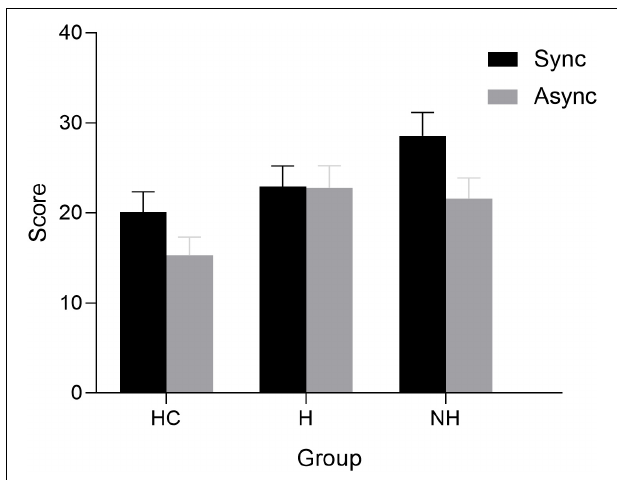
FIGURE 3 | Mean overall subjective experience score of patients with AVHs (H), patients without AVHs (NH), and healthy controls (HC) under two stimulation conditions: synchronous (Sync) and asynchronous (Async). Error bars reflect 95% confidence